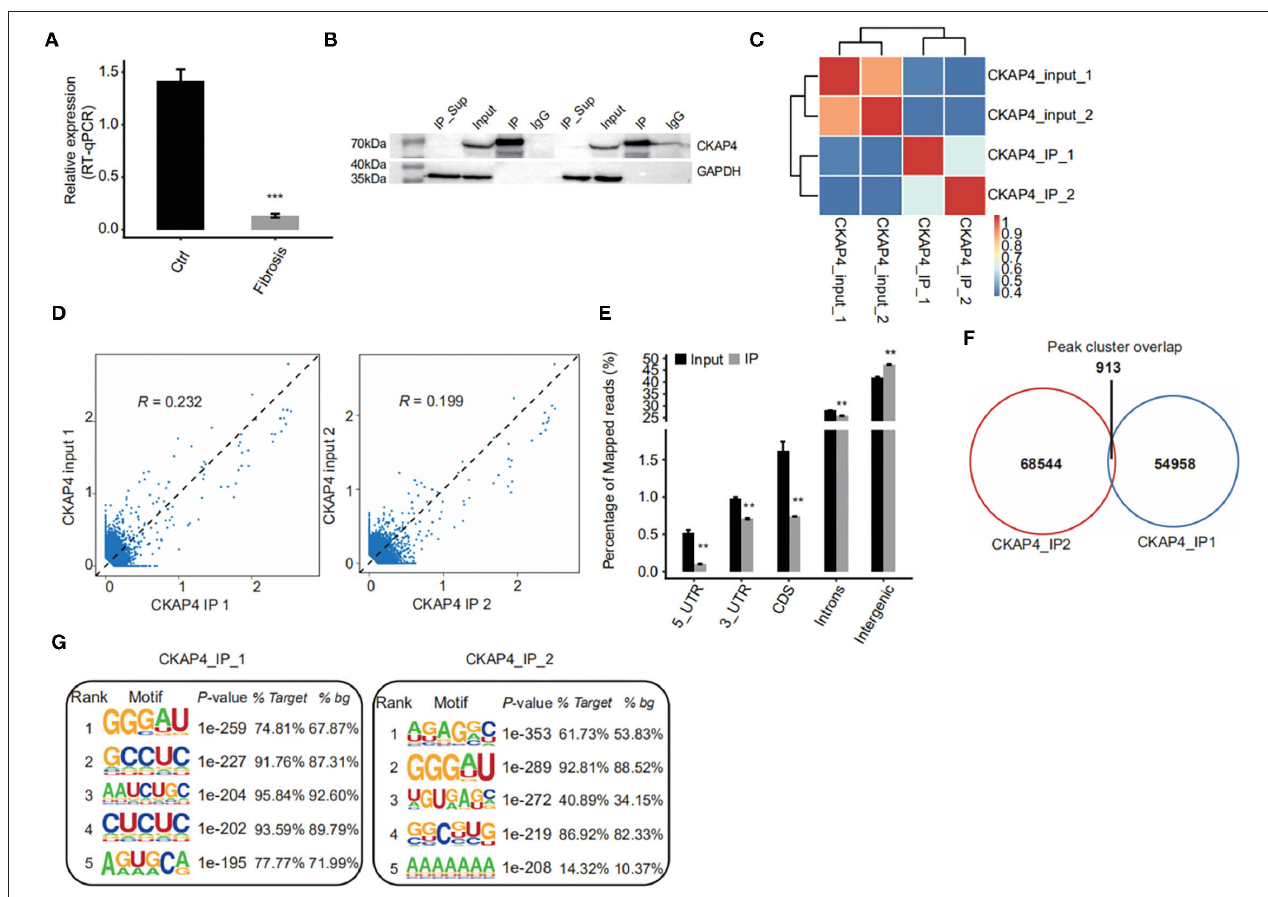
FIGURE 1 | iRIP-seq of CKAP4 in myocardial tissues. (A) CAP4 RNA level was quantified by qRT-PCR. Error bars represent mean ± SEM. *** p < 0.001. (B) CKAP4 protein detection by western blot. (C) Heat map shows the hierarchically clustered Pearson correlation matrix resulted from comparing the transcript expression values for input and CKAP4 IP samples. (D) Scatter plot of reads abundance across reference genome in paired samples. (E) Reads distribution across reference genome. Error bars represent mean ± SEM. ** p < 0.01. (F) Venn diagram of peaks identified from the IP1 and IP2 samples. (G) Top 5 overrepresented CKAP4-binding motifs identified by Homer from the iRIP-seq data.